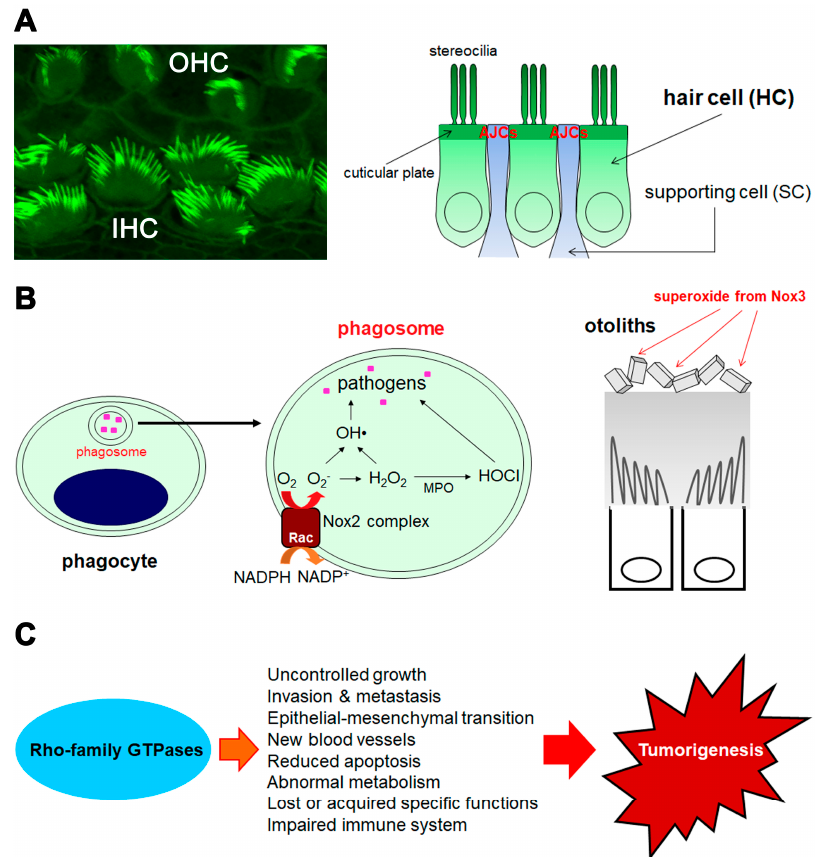
Figure 1. An overview of the main focus points of this review. ( A ) hearing function, ( B ) host defenses using ROS and Rac-dependent Noxs, and ( C ) tumorigenesis. ( A ) Inner hair cells (IHCs) and outer hair cells (OHCs) obtained from the wild-type cochlea at the age of P5 (stained by Alexa Fluor 488-labelled phalloidin). The illustration represents the mosaic alignment of HCs and supporting cells (SCs). AJCs: apical junctional complexes between HC and SC. ( B ) The illustration on the left shows phagocytes with a phagosome containing internalized pathogens (indicated by pink square). The middle illustration shows the magnified phagosome with a Nox2 complex (Rac is one of six components) on the membrane. Superoxide (O 2 − ) and reactive oxygen species (ROS) are generated in the phagosome. The illustration on the right shows the otoliths on the otolithic membrane in the vestibule. Superoxide from Nox3 is essential for the synthesis of otolith; however, the origin of superoxide (that is Nox3-expressing cells in the inner ear) is still controversial. ( C ) The scheme represents how Rho-family GTPases are involved in